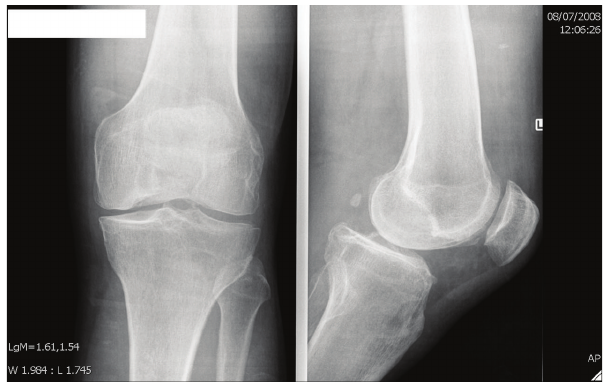
Figure 2: Anteroposterior and profile view X-rays of the knee following surgery.